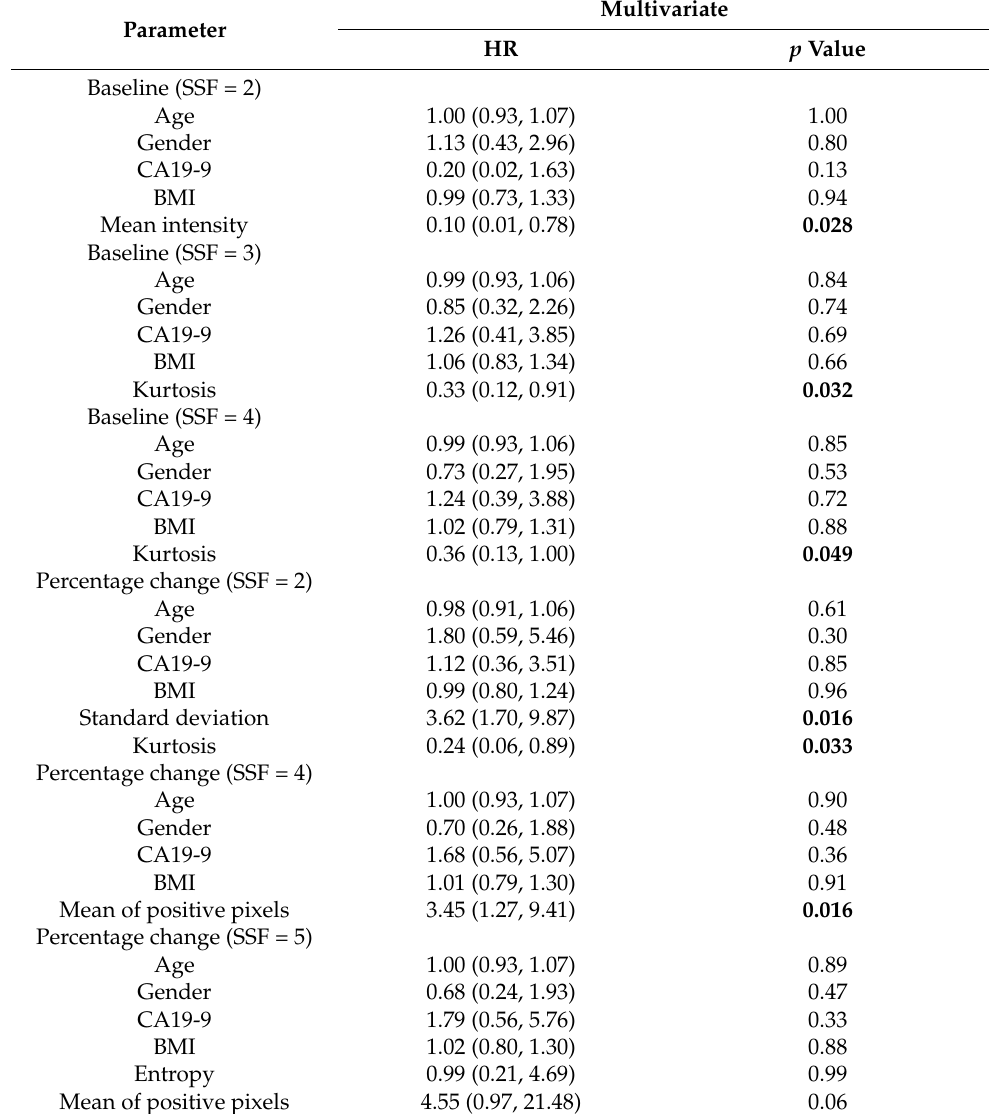
Table 7. Analysis of survival with multivariate cox regression